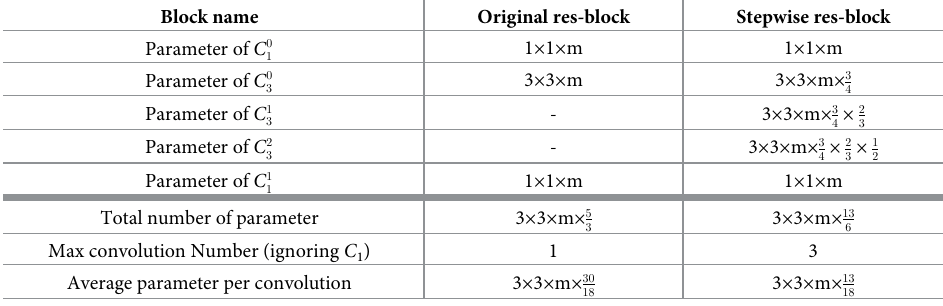
Table 2. Parameter comparison between original res-block and stepwise